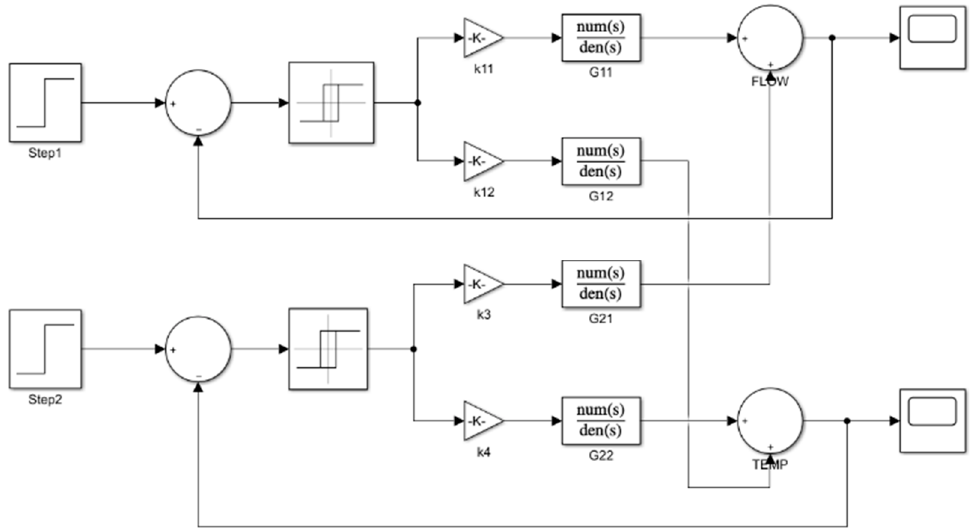
Figure 4. Simulation block diagram of environment control system (ECS) with relay feedback.